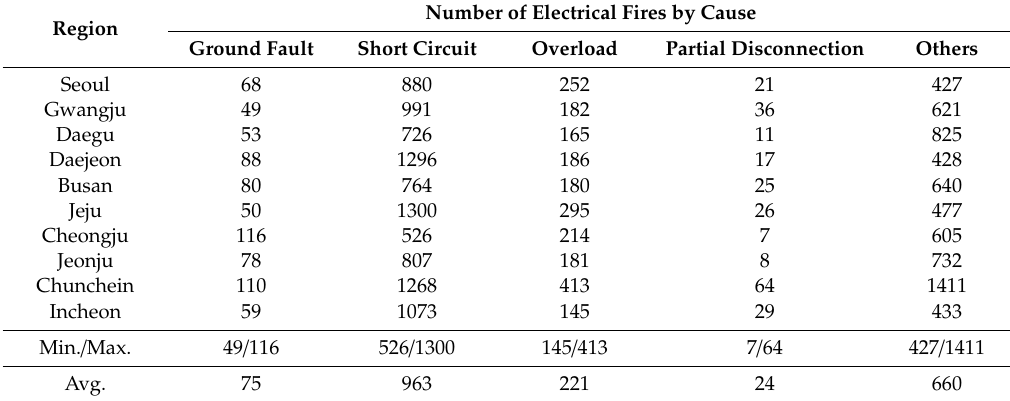
Table 4. The number of electrical fires by metropolitan city and city per 100,000 people.